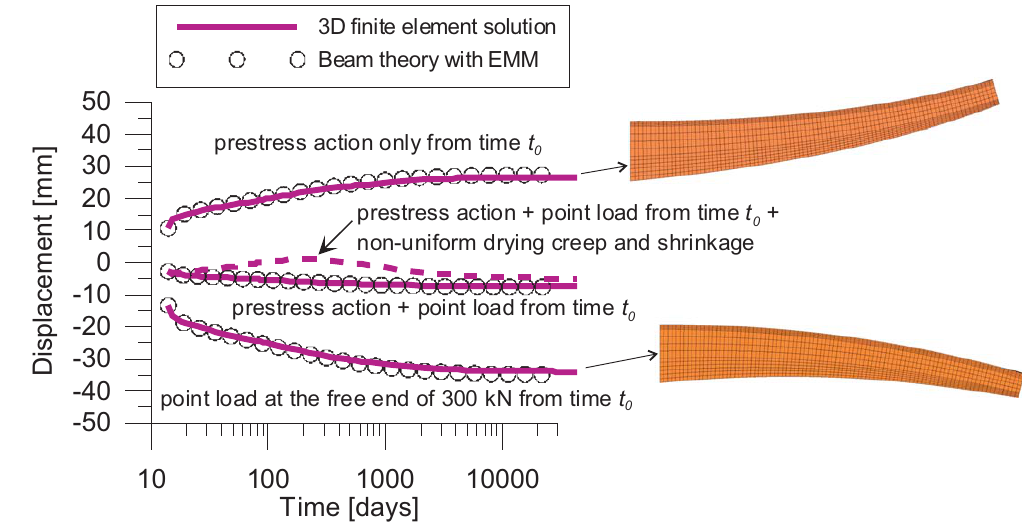
Figure 9. Mid-span deflection of the beam in Figure 4 in logarithmic scale for different loading conditions obtained by 3D finite element analysis (with the amplified deformation) and by the beam theory with the effective modulus